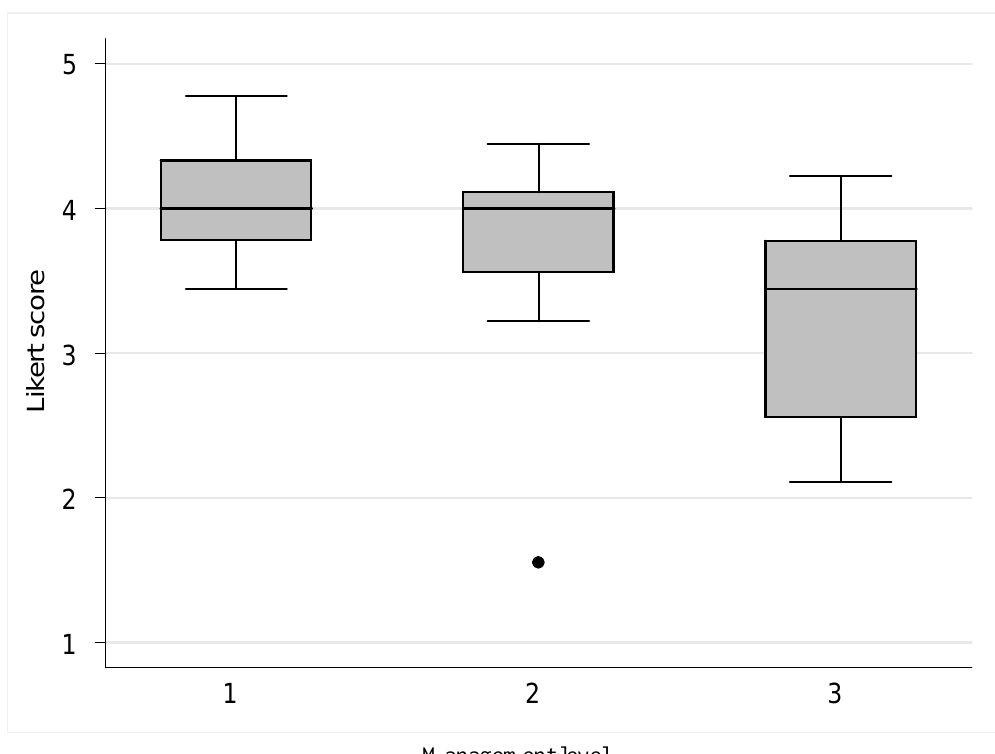
Figure 3: Management level versus PMF attainment of